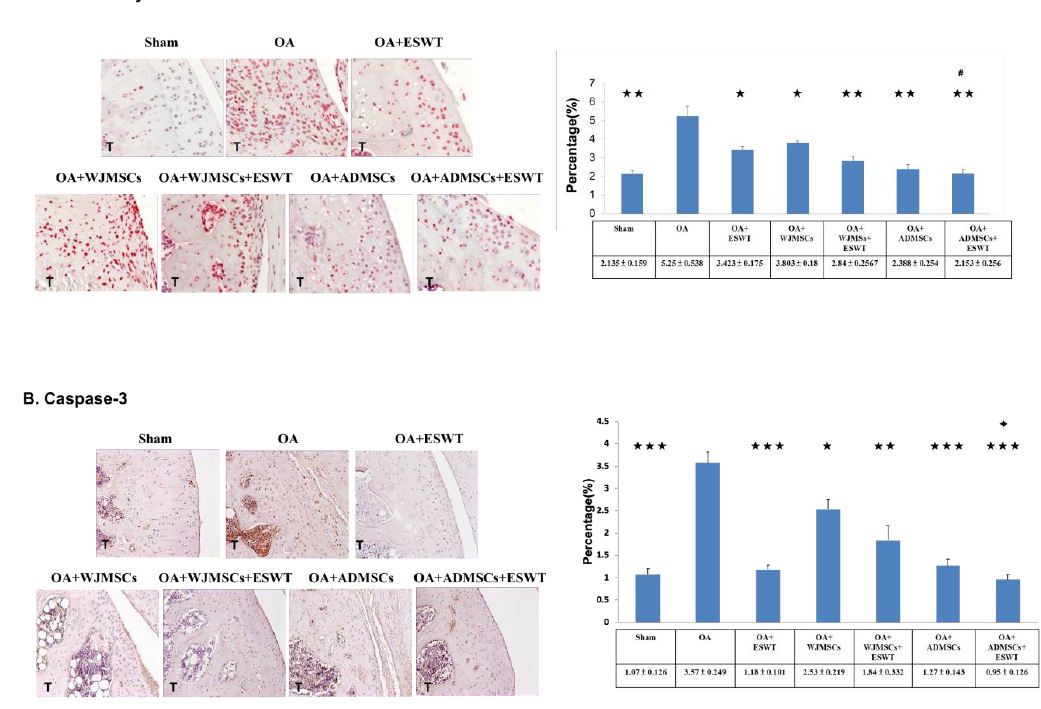
Figure 4. Immunohistochemical analysis for apoptosis markers. ( A ) TUNEL activity (×400 magnification), ( B ) caspase-3 in the experiments (left) (×200 magnification), and the level of expression that was measured after treatment (right). * p < 0.05, ** p < 0.01, and *** p < 0.001 were compared with OA; # p < 0.05 was compared among treatment groups. ✦ p < 0.05 was compared between ESWT combined with ADMSCs or WJMSCs. All rats were n = 6. Tibia is indicated as T.